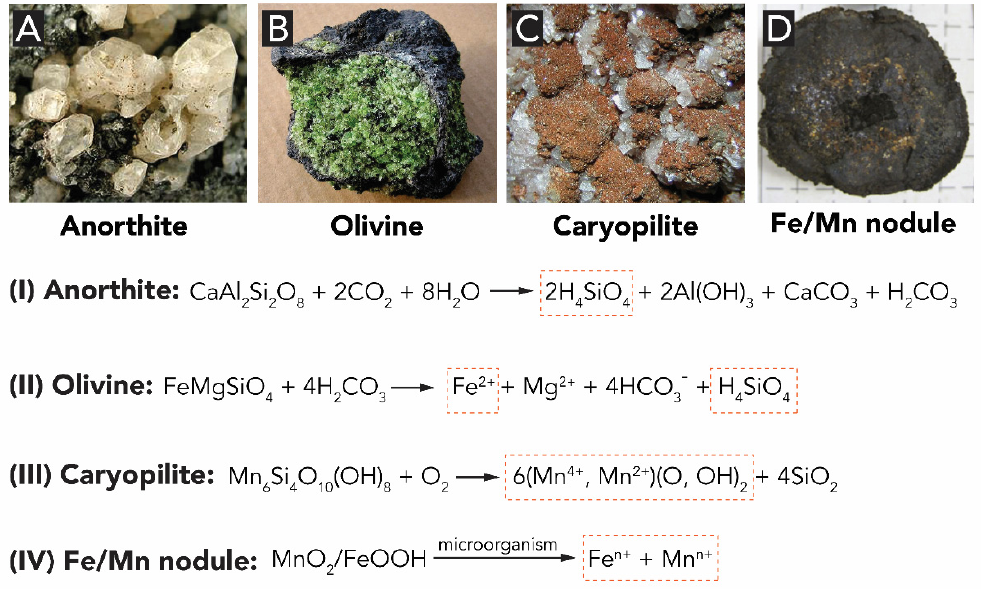
Figure 2. Representation of natural sources for the synthesis of metal oxides. ( A – C ) Examples of minerals that can suffer chemical weathering (reactions I-III) in subterraneous bedrock, releasing, e.g., iron, manganese and silicon biomineralization precursor species (as Si(OH) 4 ; (Fe 2+/3+ ) and (Mn 2+/4+ )(O,OH) 2 , highlighted by dotted boxes) to the aqueous environment. ( D ) The main sources of manganese minerals are found in the seafloor in the form of ferromanganese nodules, which release different ions through leaching. Photographs of anorthite by Rob Lavinsky, olivine by Aomai and caryopilite by Leon Hupperichs are published under Creative Commons Attribution (CC BY-SA 3.0) license. Photograph of ferromanganese nodule is reproduced from [23] with permission from the Elsevier B.V.